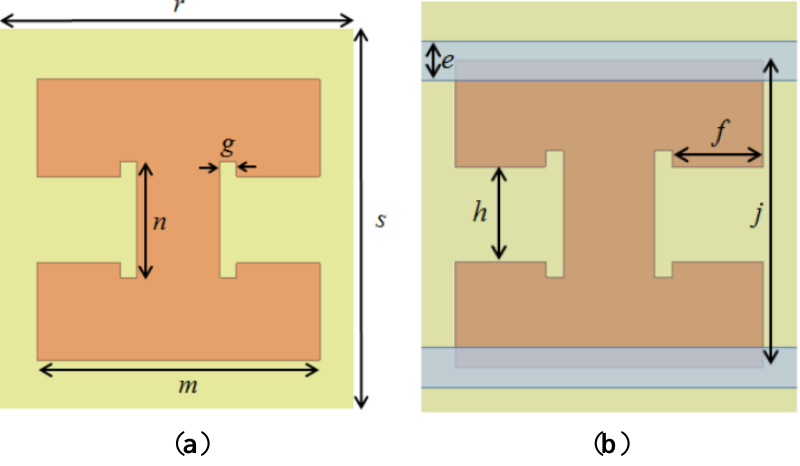
Figure 1. Layout of two metamaterial unit cells: e = 0.5 mm, f = 1.15 mm, g = 0.23 mm, h = 1.2 mm, j = 3.9 mm, m = 3.9 mm, n = 1.6 mm, r = 4.75 mm, s = 5 mm. ( a ) Primitive unit cell; ( b ) Proposed microfluidic unit